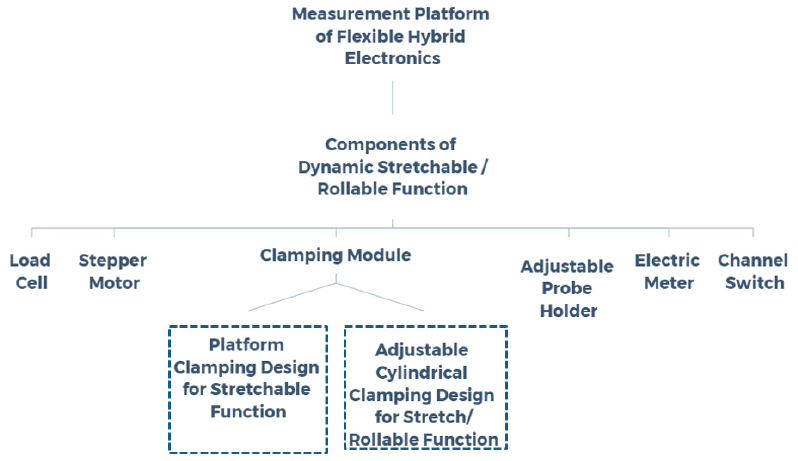
Figure 1. Designed skeleton and loading functions of the measurement platform for flexible hybrid electronics.